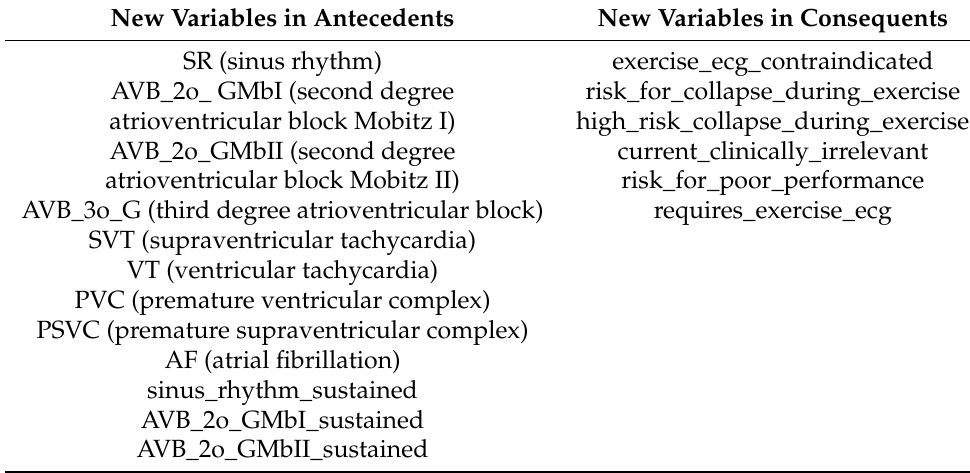
Table 4. Subsystem III (diagnoses): IIIa: arrhythmias (third level input data and conclusions/ask for more data).